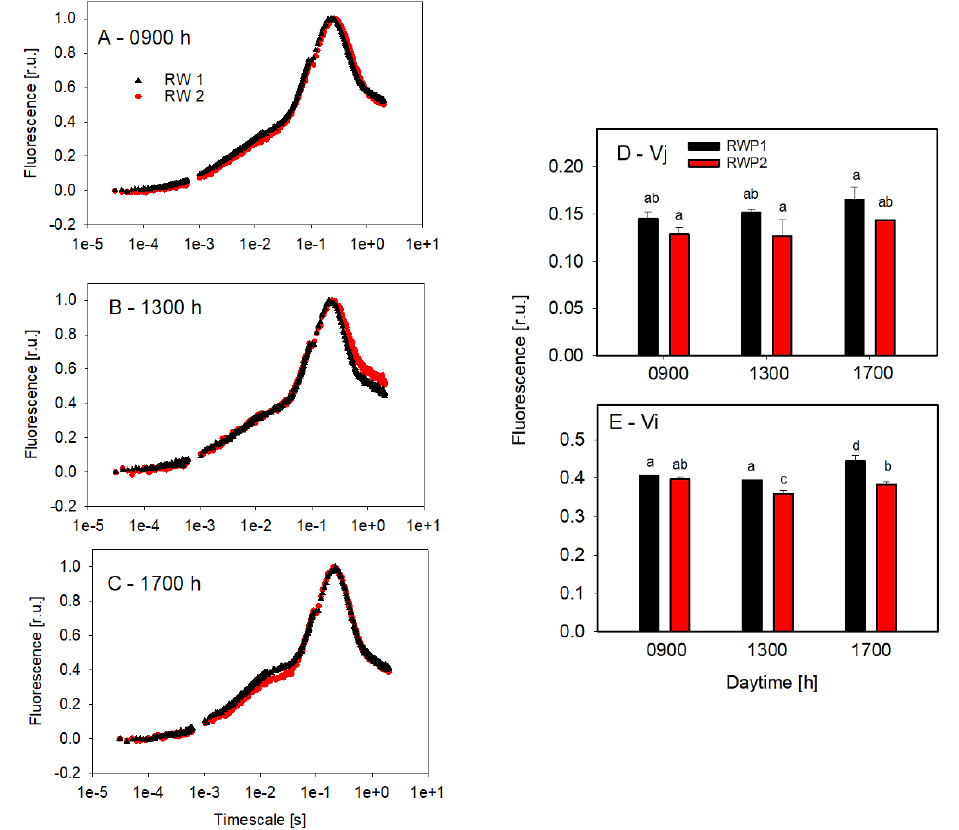
Figure 7. Curves of fast fluorescence induction kinetics measured ex-situ in the culture samples taken at 09:00 h ( A ), 13:00 h ( B ), and 17:00 h ( C ) from the bioreactors RWP1 and RWP2 during outdoor trials in M é rida. Each curve is an average of 3–5 measurements which were double normalized to the minimum (F 0 ) and maximum points (Fm). The curve designation is identical in panels (A–C) and the column designation is the same in panels (D,E). Variables Vj ( D ) and Vi ( E ) were estimated from fast fluorescence induction curves. The mean values designated by the same letter did not differ significantly from each other.